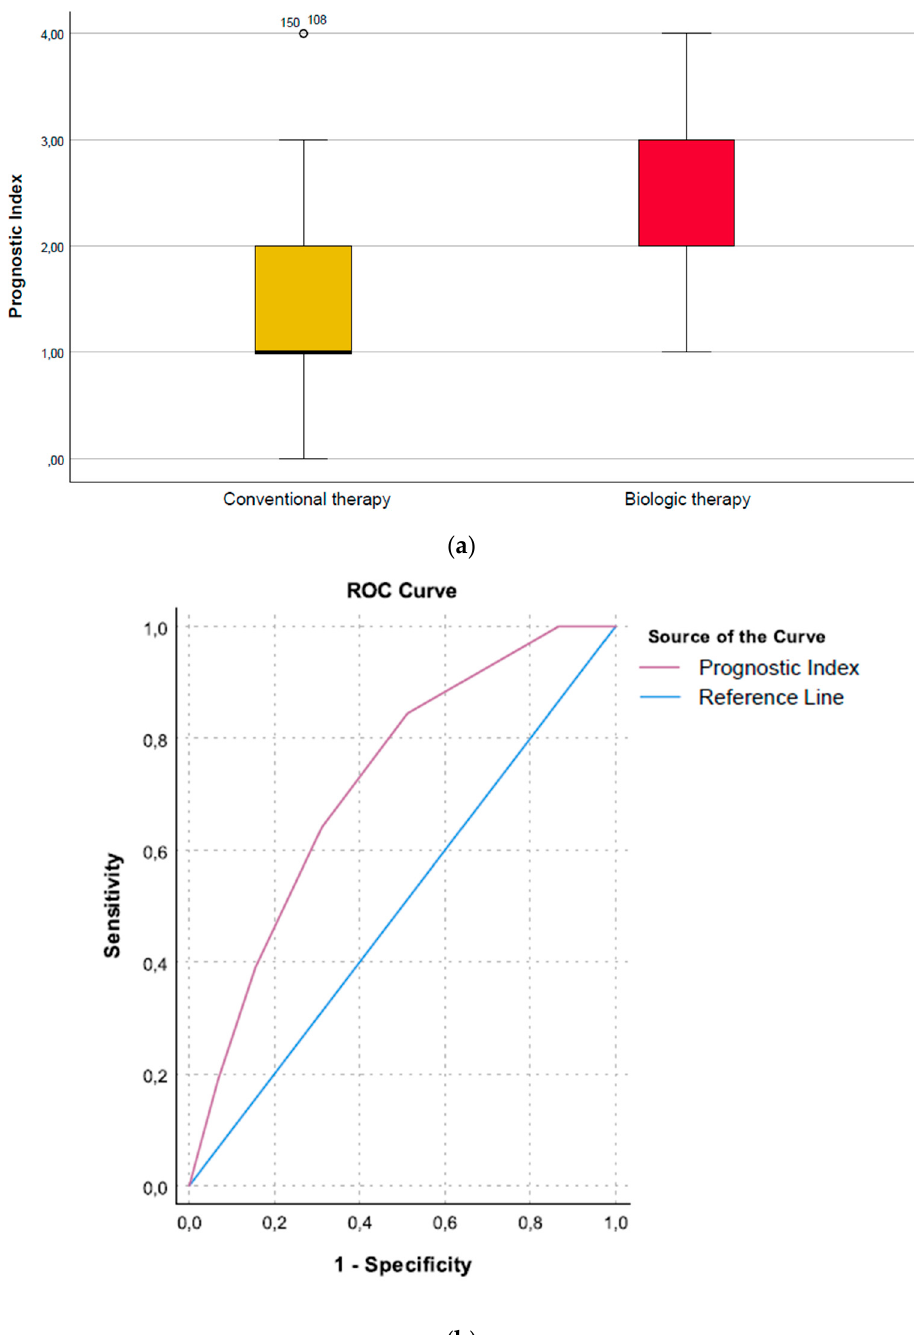
Figure 5. ( a ) Prognostic Index showing the need for biological therapy; ( b ) Roc curve showing the AUC of the Prognostic Index showing the need for biological therapy.